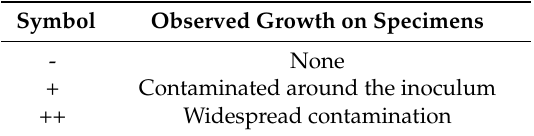
Table 2. Expression of results coming from